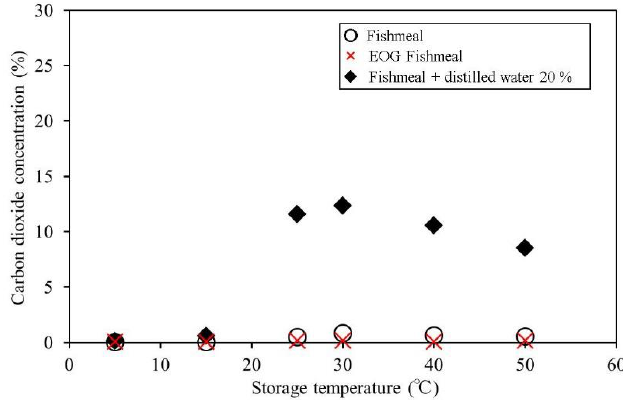
Figure 21. Carbon dioxide concentrations as functions of storage temperature for fishmeal samples.